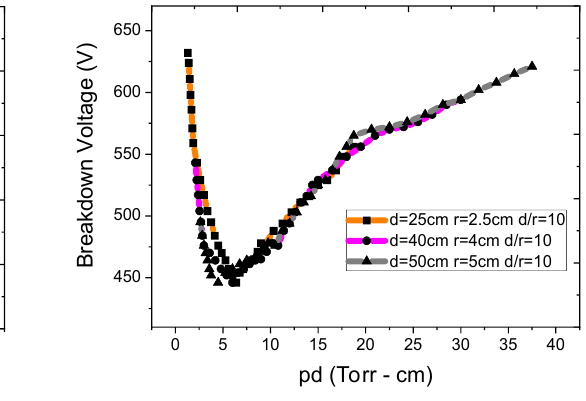
Figure 3: Paschen’s curves for the same d/r